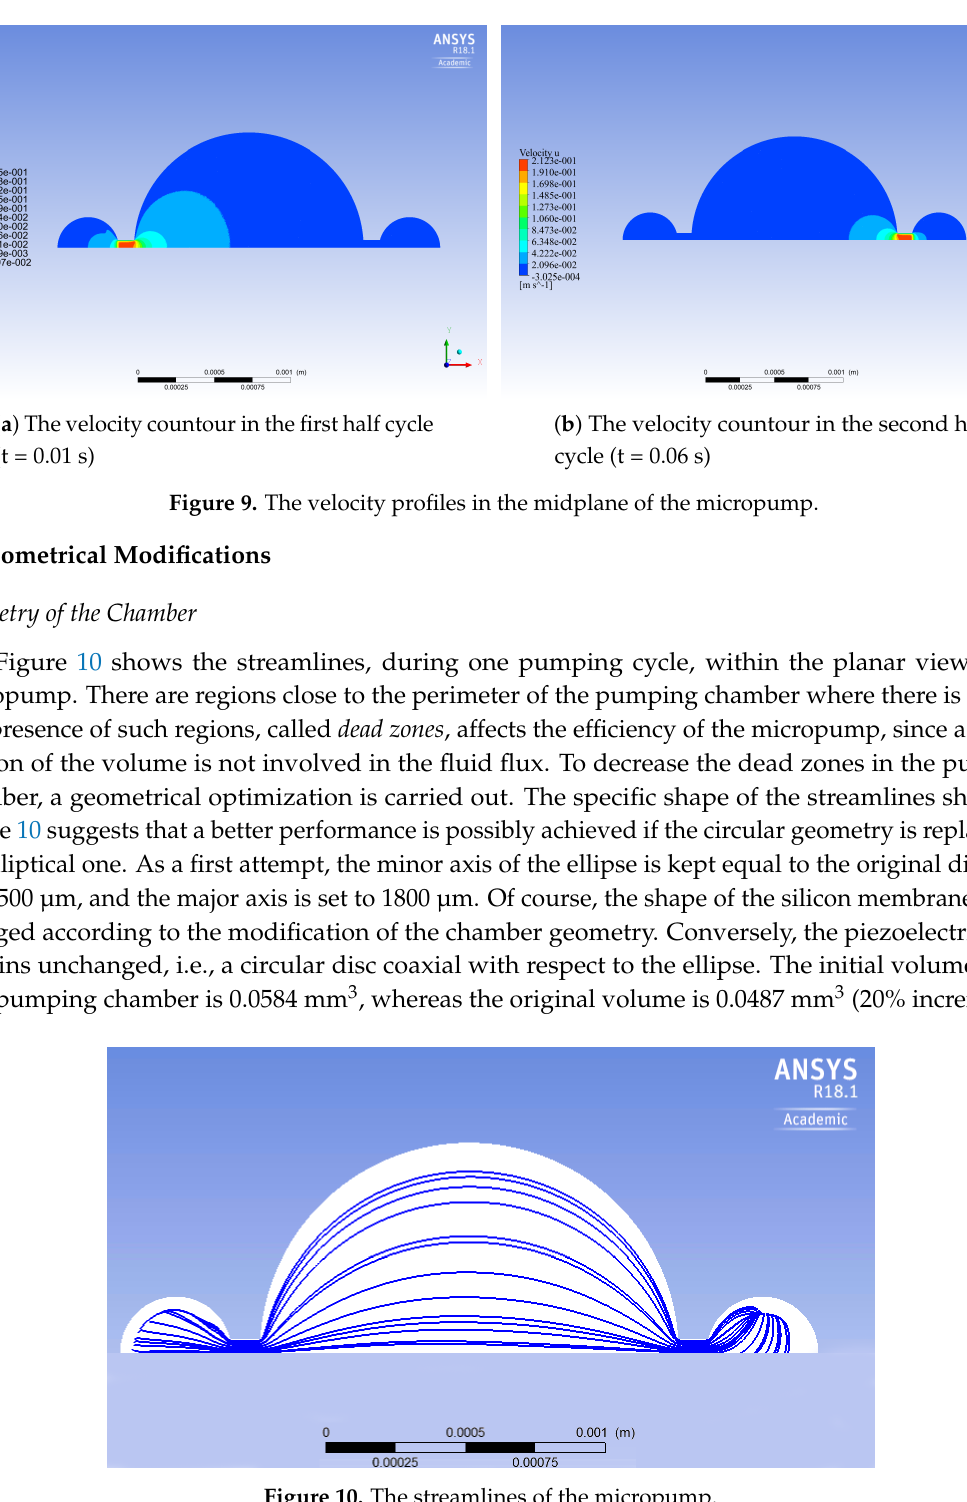
Figure 10. The streamlines of the